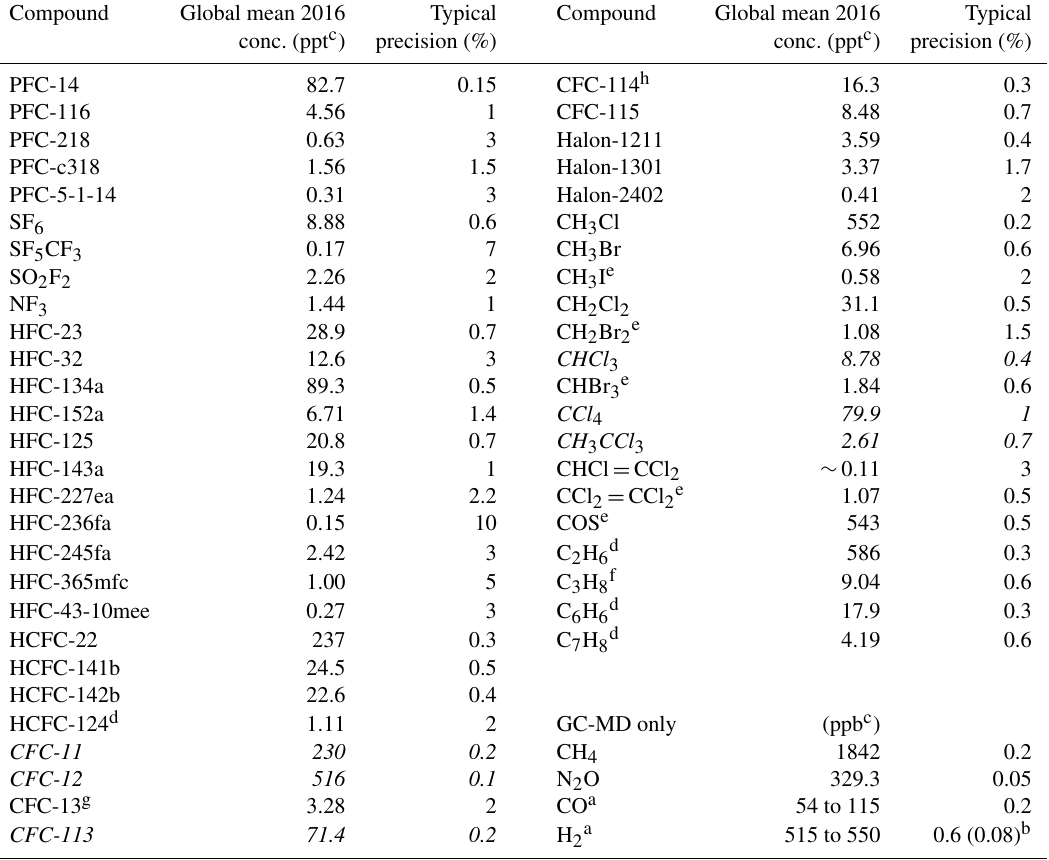
Table 1. Primary AGAGE measured species using Medusa GC-MS and GC-MD systems. Gases measured with Medusa GC-MS and GC- MD only are in black regular font; those measured with both systems are in italic font. Calibrations are on AGAGE SIO gravimetric scales (Sect. 2.6) unless otherwise